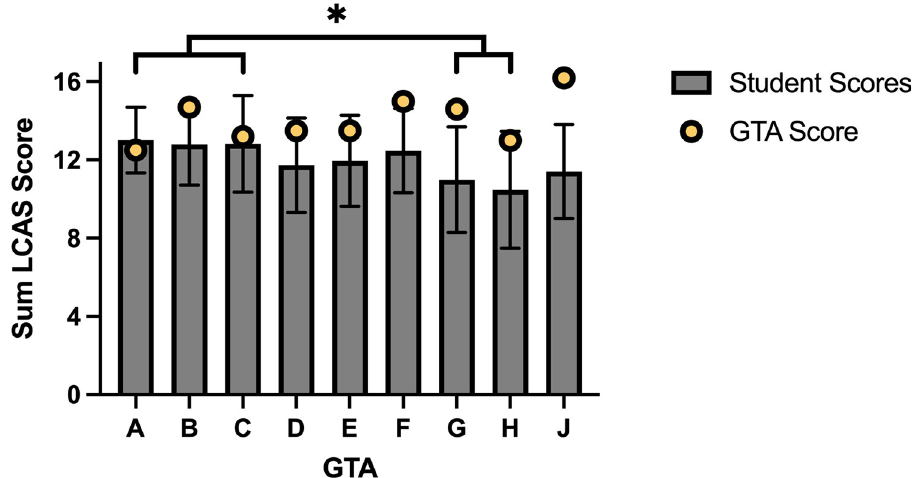
Fig 3. GTAs impact student perceptions of essential CURE constructs, and perceive greater presence of CURE constructs in the curriculum than their students. Grey bars represent the summed average ( ± 1 SD) of the three constructs measured in the student LCAS ( Collaboration , Iteration , and Broader Relevance/Novel Discovery ) for students of each GTA. Students of GTAs A, B, and C perceive significantly higher elements of research in their classes than do students of GTAs G and H. Yellow circles represent the summed average of the three constructs for each GTA’s LCAS score, allowing for comparison of the GTA’s perspective of facilitating Collaboration, Iteration, and Broader Relevance/Novel Discovery to student’s perceptions of experiencing those research elements. Most GTAs perceive similar or slightly higher levels of research elements in their CURE classrooms as their students. However, three GTAs (F, G, and J) perceive notably higher levels of these research elements in their class than their students.